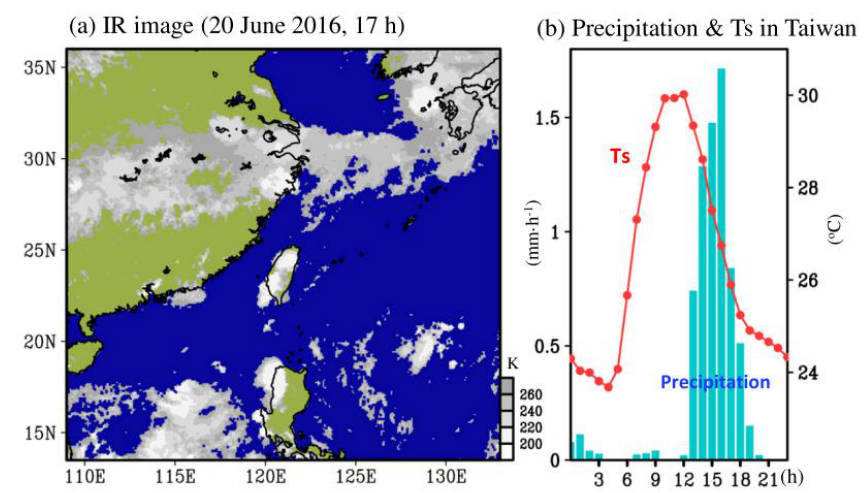
Figure 7. ( a ) Infrared cloud image, obtained from Gridded Satellite B1 Observations (https://www.ncdc.noaa.gov/gridsat/), for an example of convective afternoon rainfall (CAR) event that occurred on 20 June 2016, 17 h (local time) in Taiwan. ( b ) Time series of hourly precipitation (bars) and surface temperature (Ts, red line) averaged from local stations in Taiwan for the event shown in ( a ).